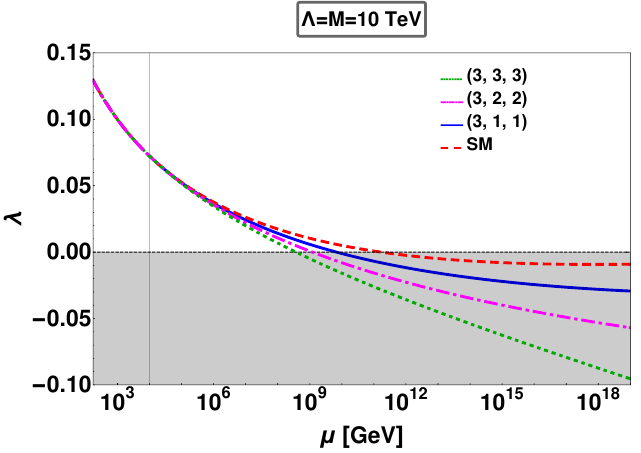
Figure 2 . Comparing the evolution of the quartic Higgs self-coupling λ in the SM (dashed, red) with various inverse-seesaw extensions with explicit lepton number violation: (3,1,1) denoted in solid (blue), (3,2,2) dot-dashed (magenta) and (3,3,3) dotted (green), see text for details.